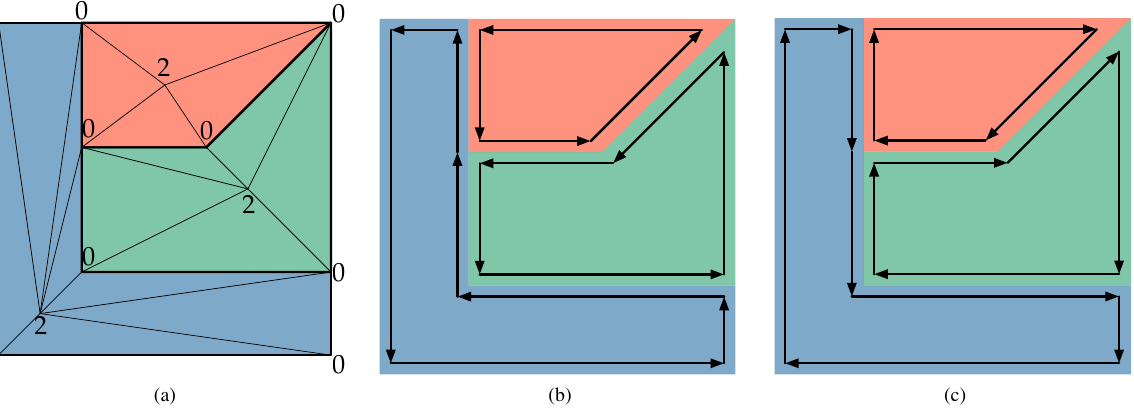
Figure 7: A 2D combinatorial map representing three polygons. (a) The underlying simplicial complex, where every triangle consists of two vertices (marked as 0) at either end of an edge and a symbolic vertex for every face (marked as 2). (b) The combinatorial map that is generated by choosing a counterclockwise orientation for the polygons. (c) Same for the clockwise orientation. Darts are represented by triangles in (a) and arrows in (b) and (c).